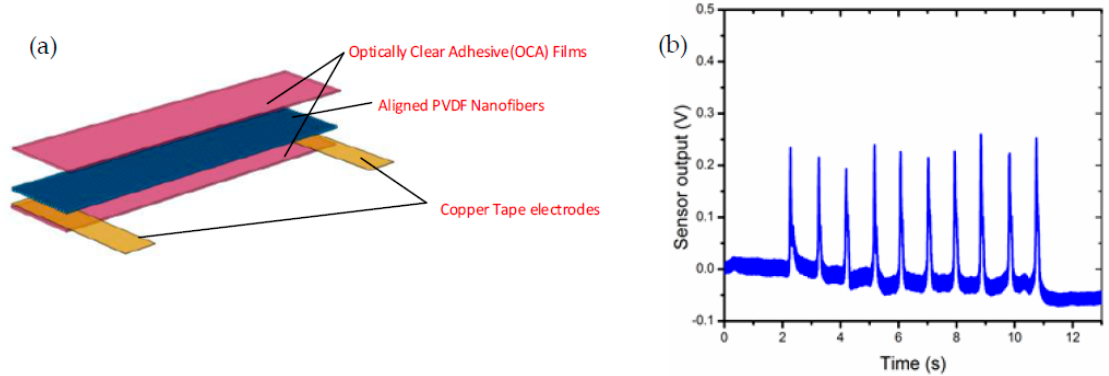
Figure 3. ( a ) Schematic illustrating the device design. ( b ) Plot showing the sensor response when subjected to periodic